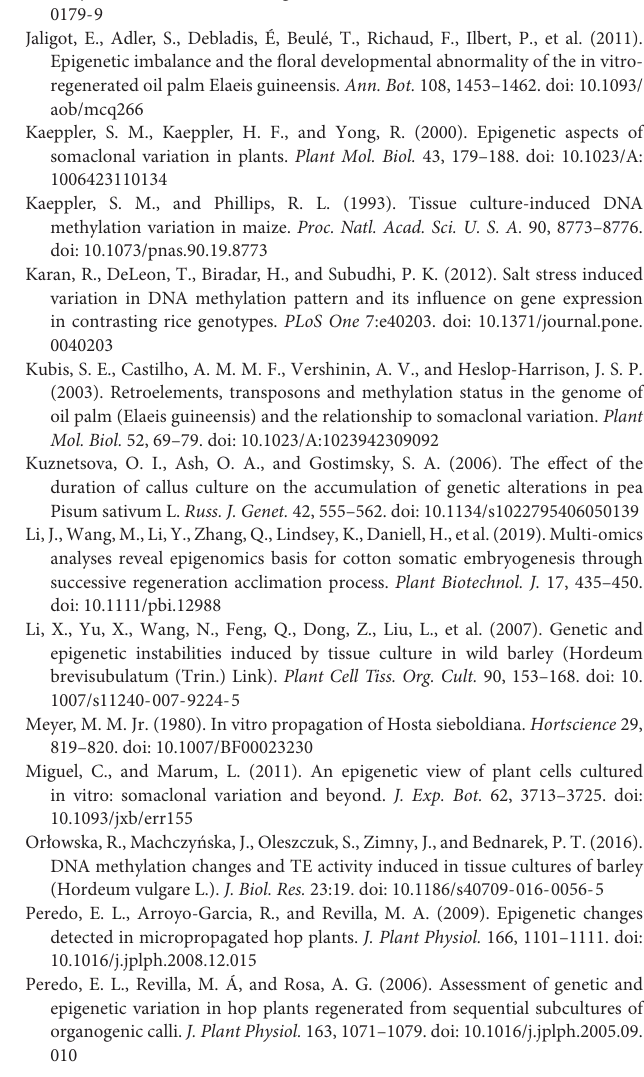
Supplementary Figure 1 | Electrophoretogram of